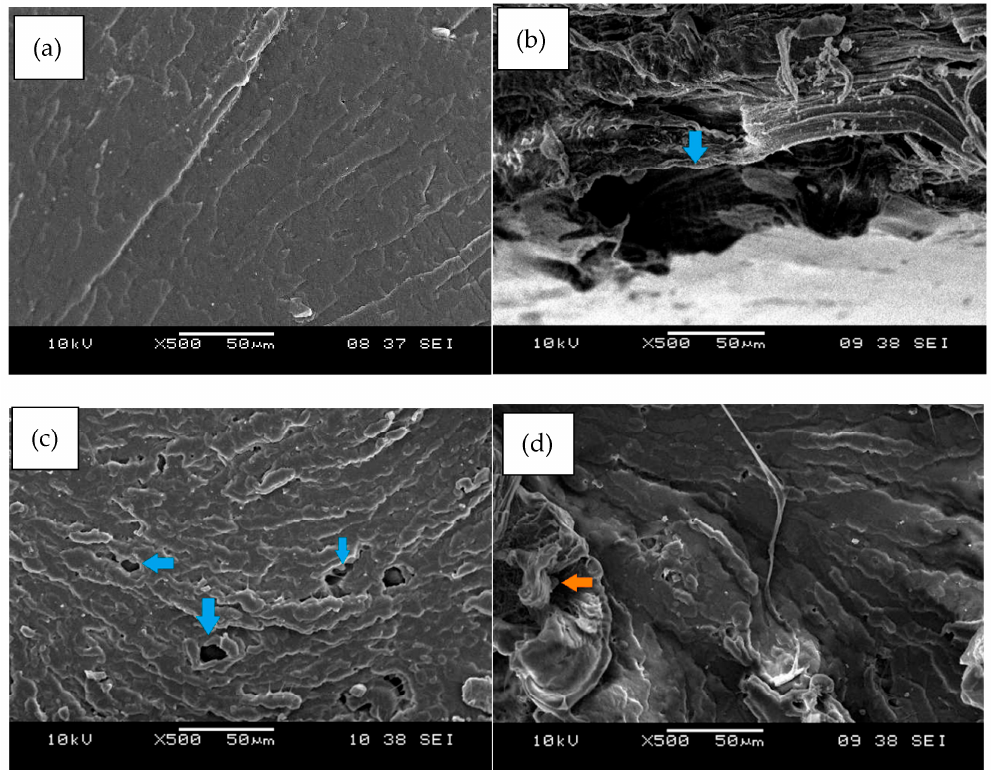
Figure 14. Fracture surface morphology of ( a ) PEVAc, ( b ) PEVAc/RD (The arrow shows the large void on the surface of the matrix ( c ) PEVAc/DNP (The arrows show tiny voids on the surface of the matrix), and ( d ) PEVAc/NP-DNP (The arrow shows the embedded dolomite in the matrix). The fractured surface of the PEVAc/DNP showed the presence of several tiny voids due to the debonding effect of the filler and the polymer matrix (see Figure 14c). As men- tioned earlier, even though their tensile strength increased, it was not as high as the tensile